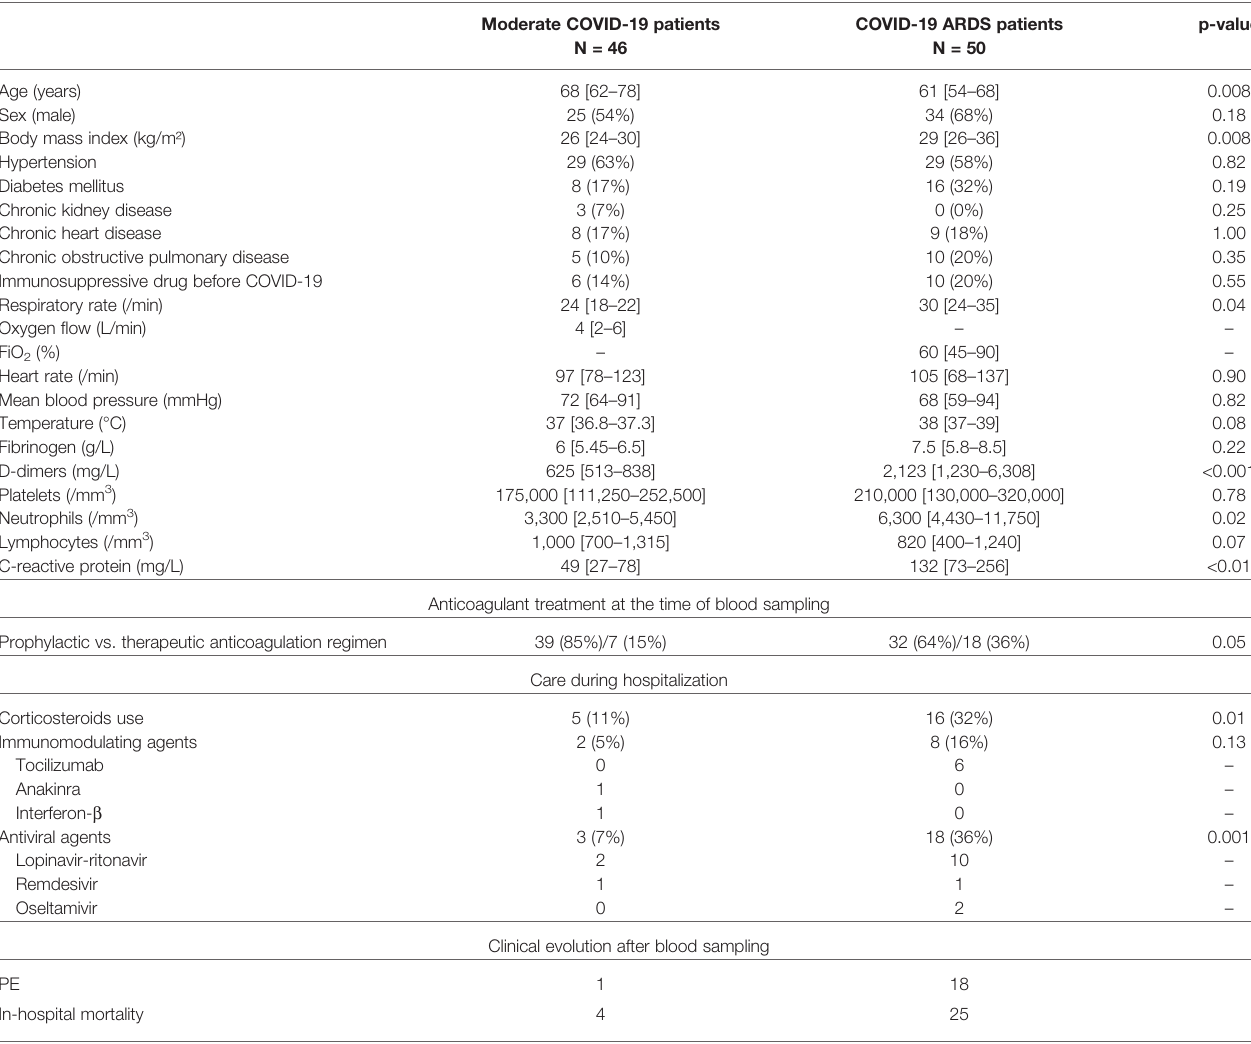
TABLE 1 | Patients ’ characteristics at the time of blood